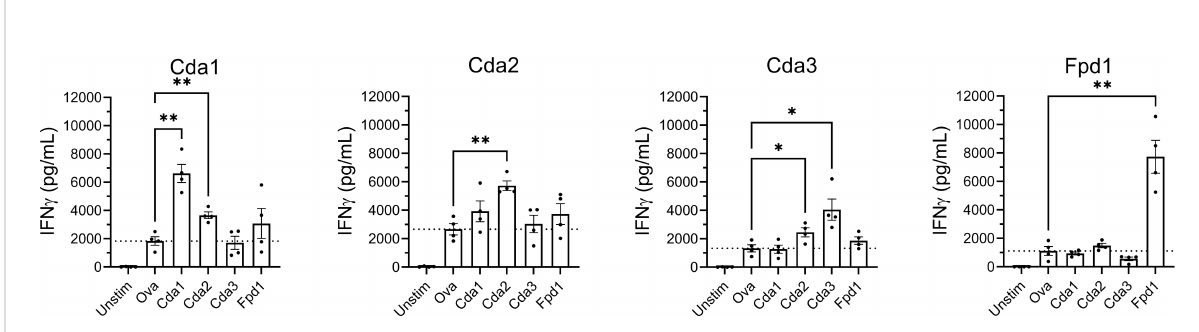
FIGURE 3 Ex vivo stimulation of splenocytes from mice vaccinated with Cda proteins induce an IFN g response to other protein family members. For Cda family proteins, BALB/c mice were vaccinated 3 times subcutaneously with 5 m g of antigen/dose adjuvanted with CAF01. Two weeks after the fi nal vaccination, splenocytes were prepared from harvested spleens and 10 6 cells/well left unstimulated (Unstim), or cultured with the indicated recombinant protein as denoted under the X axis. After 3 days of culture, the supernatants were analyzed for IFN g by ELISA. Data are expressed as means ± the standard error of the mean. N=4 mice/group; each dot represents the average of two technical replicates for a single mouse. The dotted horizontal line represents the mean IFN g production of cells stimulated with Ova. Recombinant Ova was expressed in E. coli and puri fi ed following the same protocol as recombinant cryptococcal proteins. Signi fi cance was determined by one-way ANOVA with Welch ’ s correction; comparisons were made to Ova. * signi fi cant at P ≤ 0.01; ** signi fi cant at P ≤ 0.001